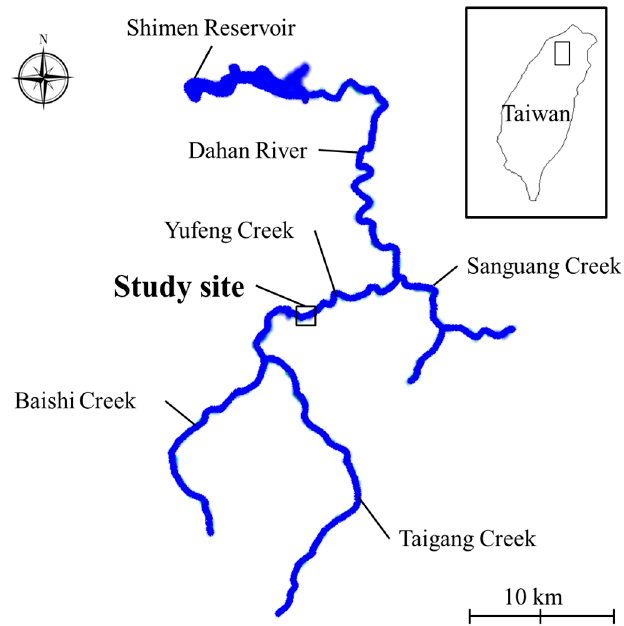
Figure 1. Location map of the study site. The Yufeng Creek is an upstream tributary of the Dahan River.